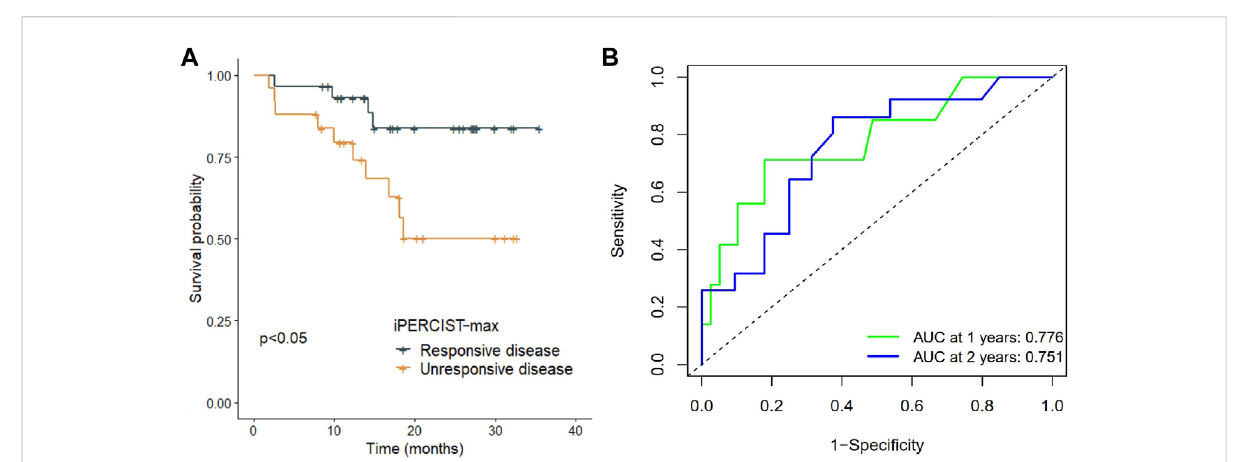
FIGURE 5 Survival difference in iPERCIST-max groups and internal validation of the robustness of iPERCSIT-max. (A) Kaplan-Meier estimated event-free survivalbetweentheresponsivediseasegroupandunresponsivediseasegroupstrati fi edbyiPERCIST-max. (B) Time-dependentreceiver-operating- characteristics (ROC) analysis for assessment of